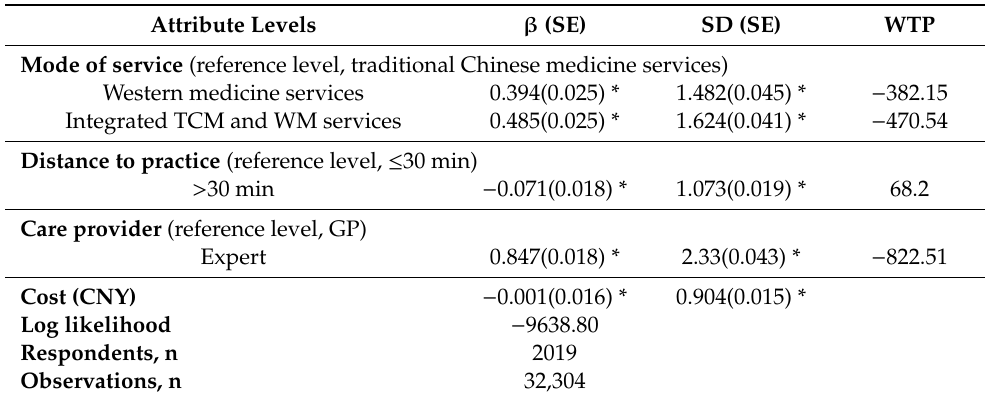
Table 4. Results of mixed logit regression analysis and